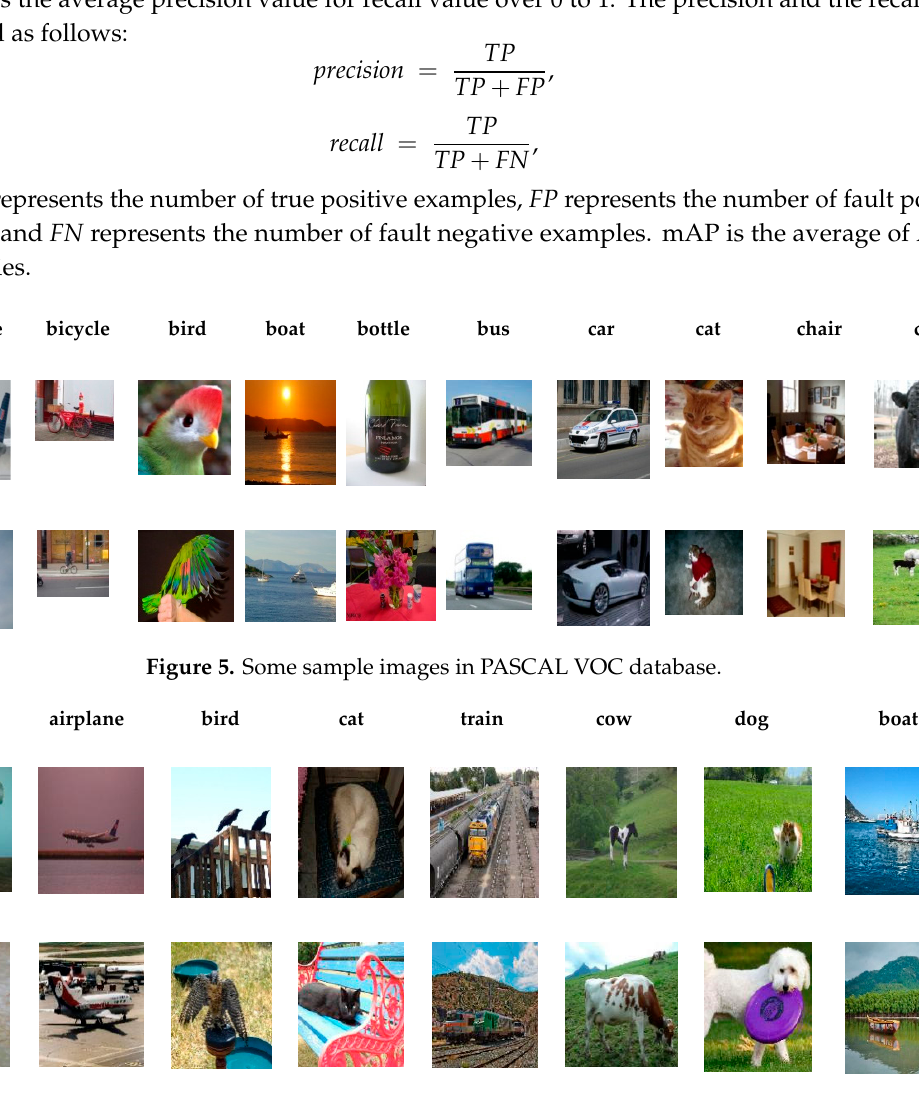
Figure 6. Some sample images in MS COCO database.